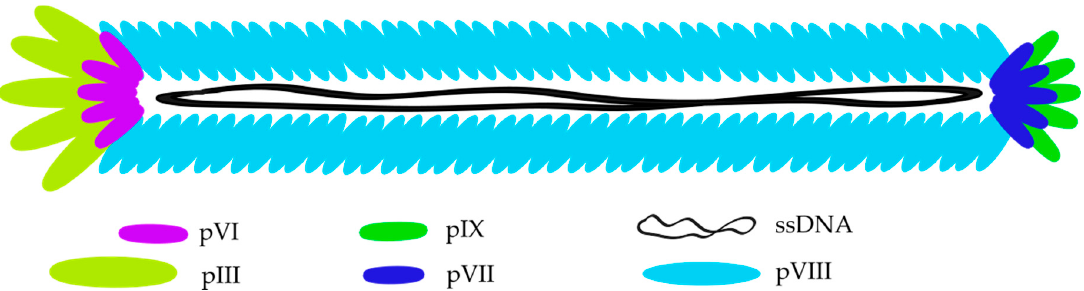
Figure 1. Scheme of M13 bacteriophage structure. Five types of coat proteins are presented with their localizations on phage particles but without a scale of proteins’ size. The phage capsid covers single-stranded DNA and forms a rod-like structure 800 nm in length and 6.6 nm in diameter [41]. Wild-type M13 has approximately 5 copies of pIII, pVI, pVII and pIX coat proteins and about 2700 pVIII copies. Minor coat protein pIII is the biggest phage coat proteins and it allows the infection of cell host.